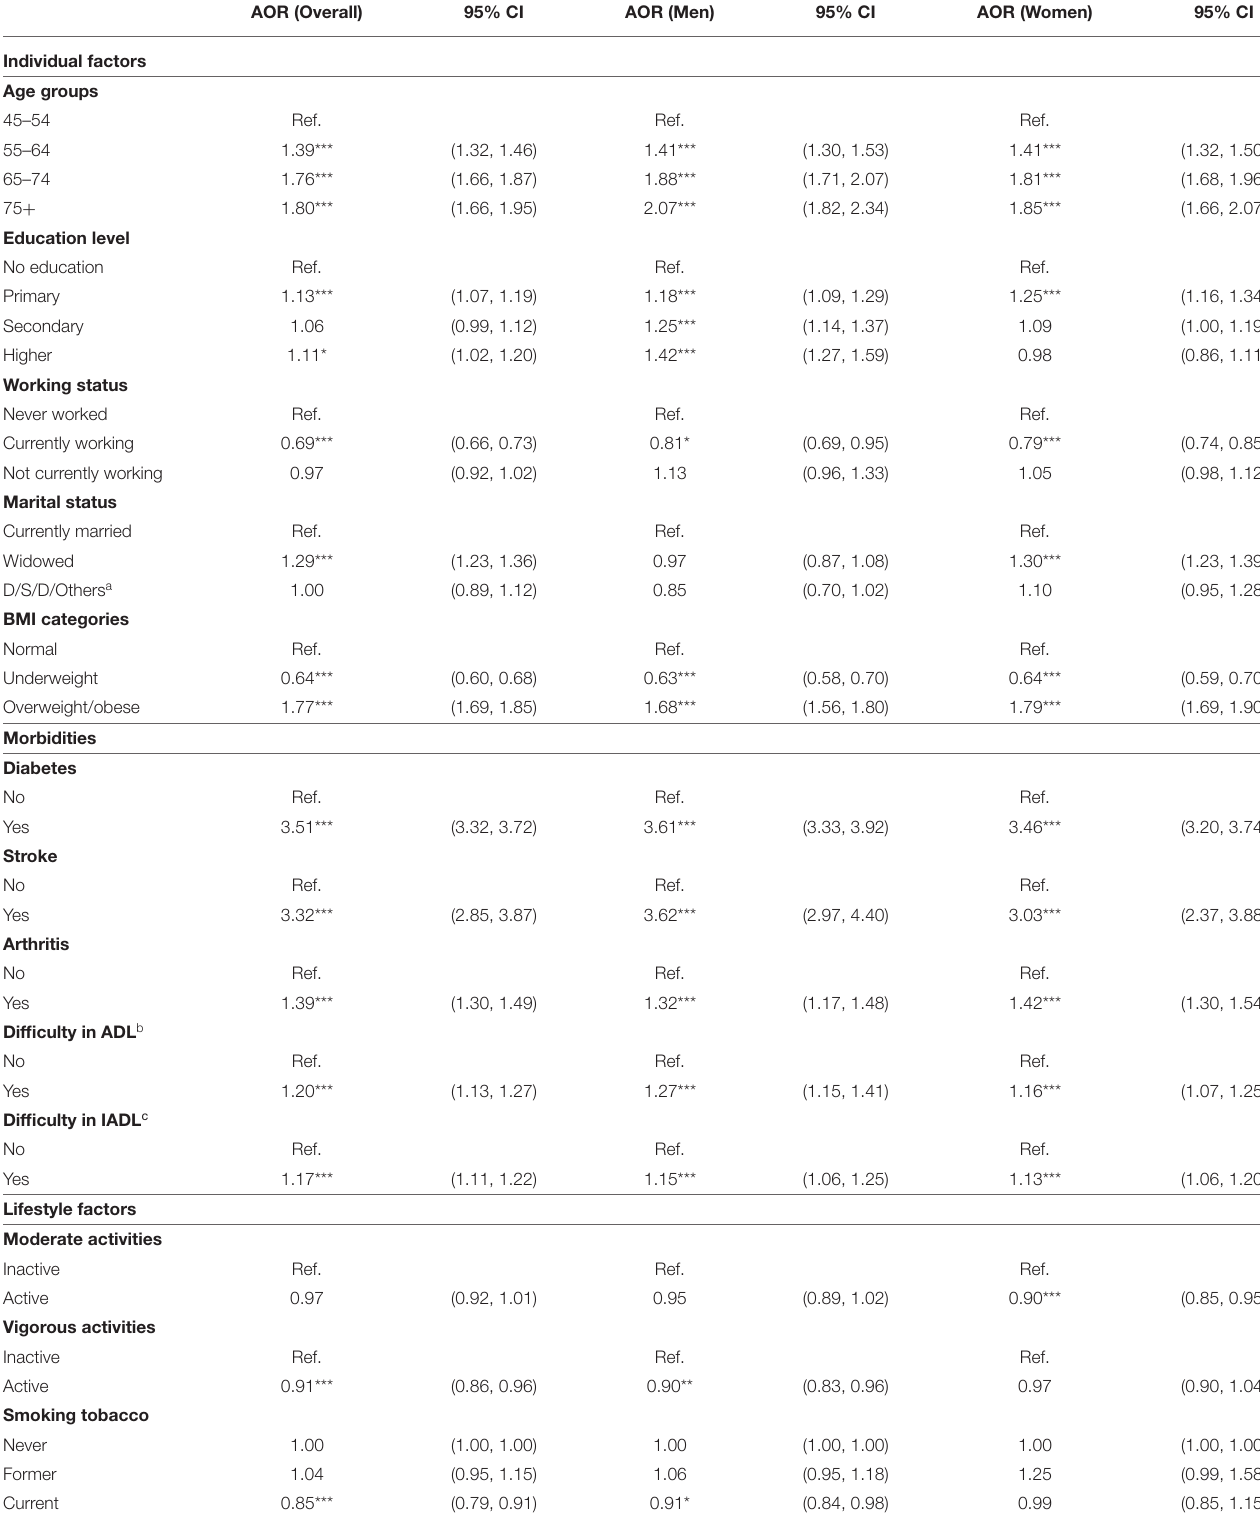
TABLE 2 | Logistic regression results for self-reported hypertension among older adults, India, LASI,